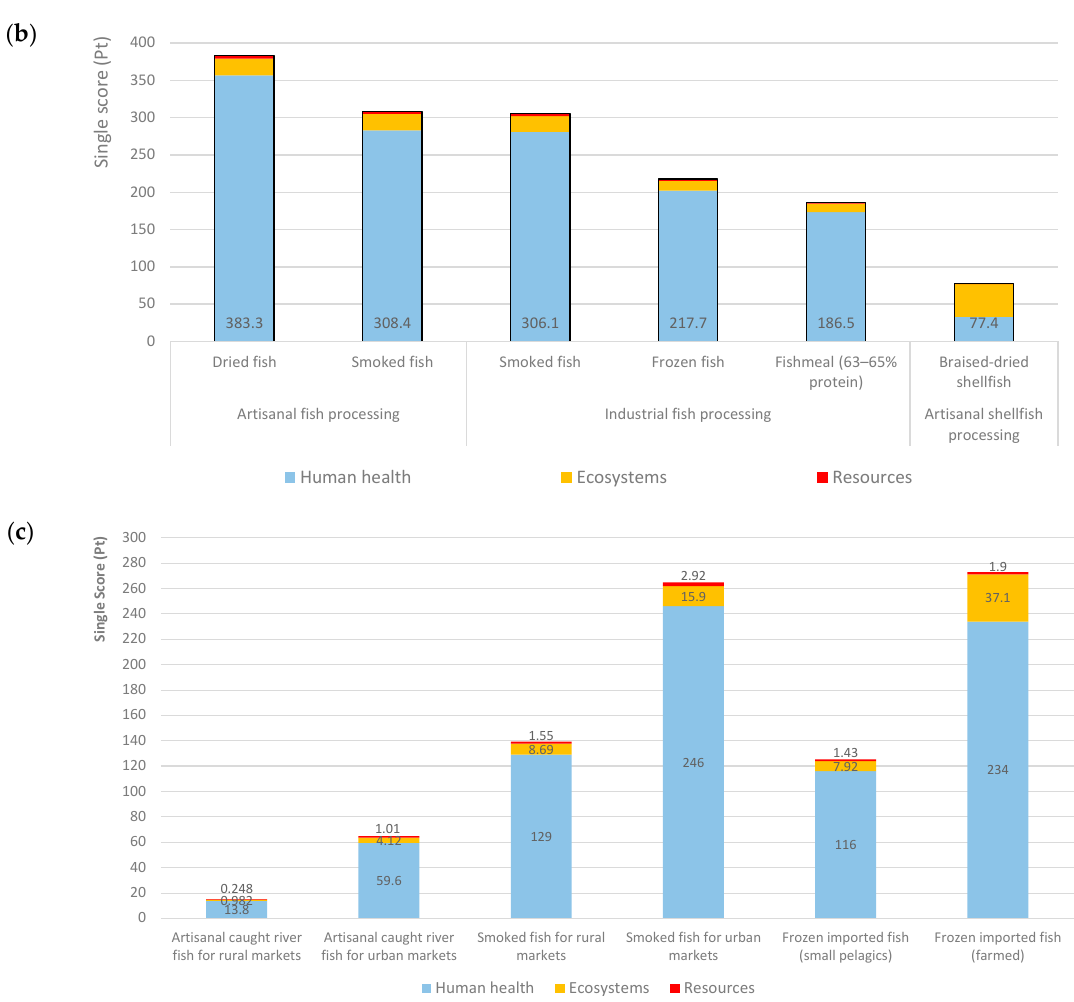
Figure 2. Endpoint environmental impacts per t of product and per area of protection: ( a ) average fish captures in the Gambia, ( b ) processed products in the Gambia and ( c ) average fish products in Mali.